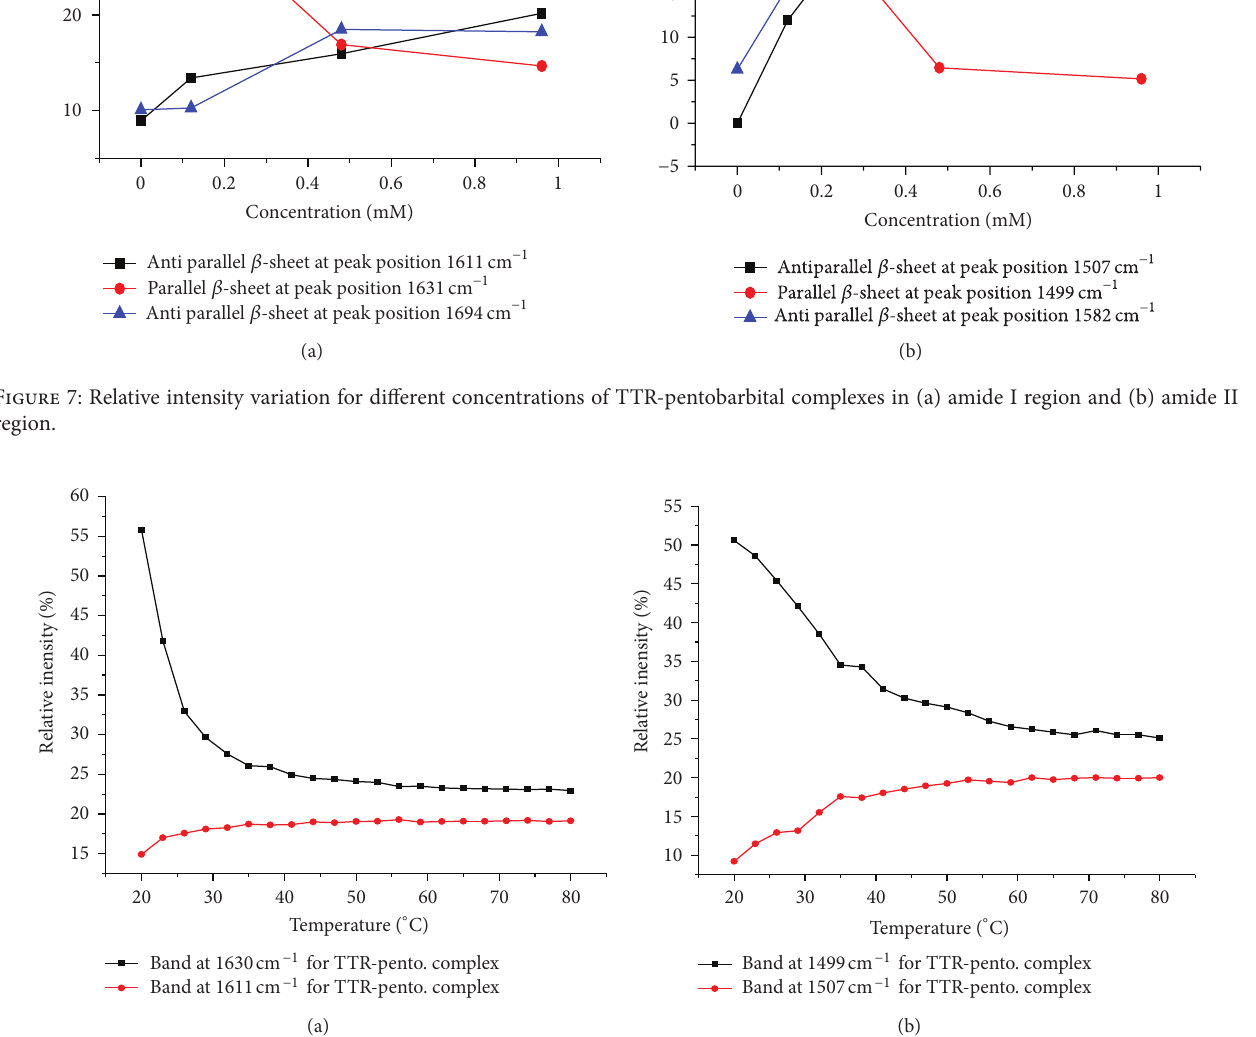
−1 band at 1507cm